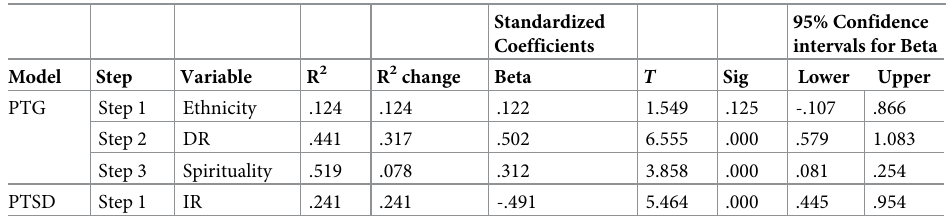
Table 5. Summary of hierarchical regression